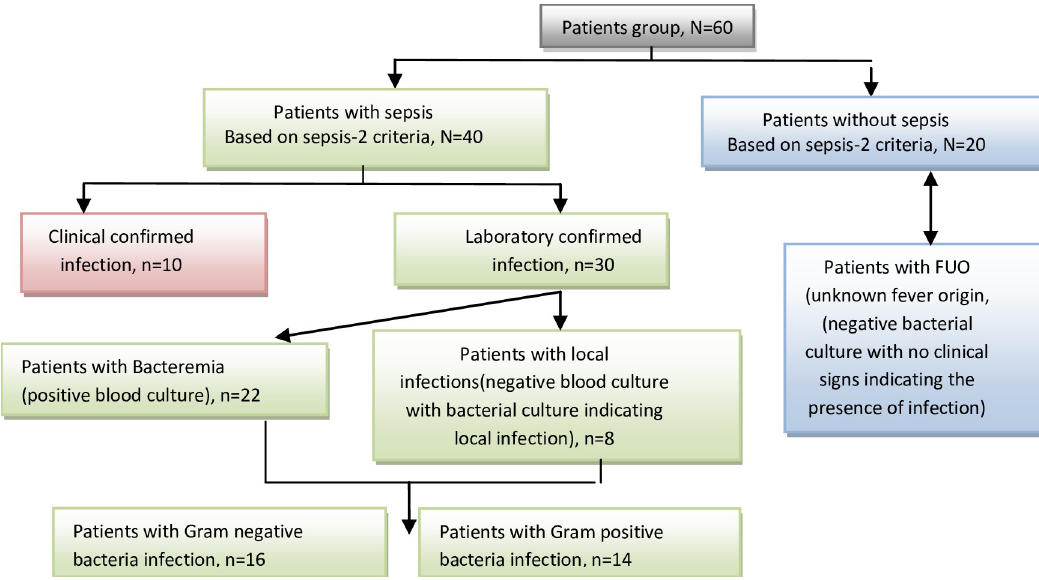
Fig 1. Distribution of patients’ groups were according to bacterial